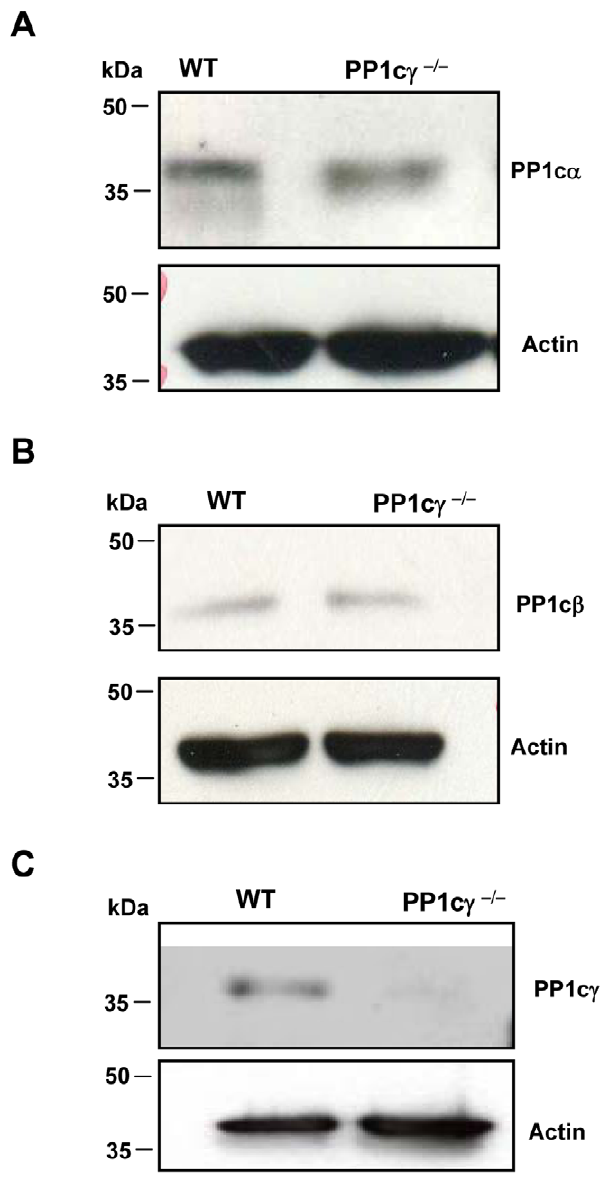
Figure 1. PP1c isoforms in platelets. ( A–C ) Platelet lysate from wild type (WT) or PP1c c 2 / 2 mice were evaluated by SDS-PAGE and Western blotting using isoform specific antibodies to a , b and c (recognizes c 1 and c 2 splice variants). These membranes were stripped and reprobed with actin to demonstrate equal protein loading (lower panels). Blots are representative of three independent experiments.